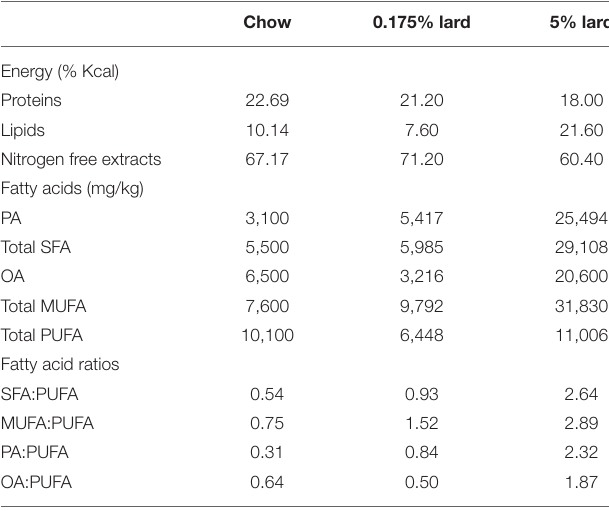
TABLE 1 | Composition of chow, 0.175% and 5% lard diets in terms of energy (%Kcal) and fatty acid